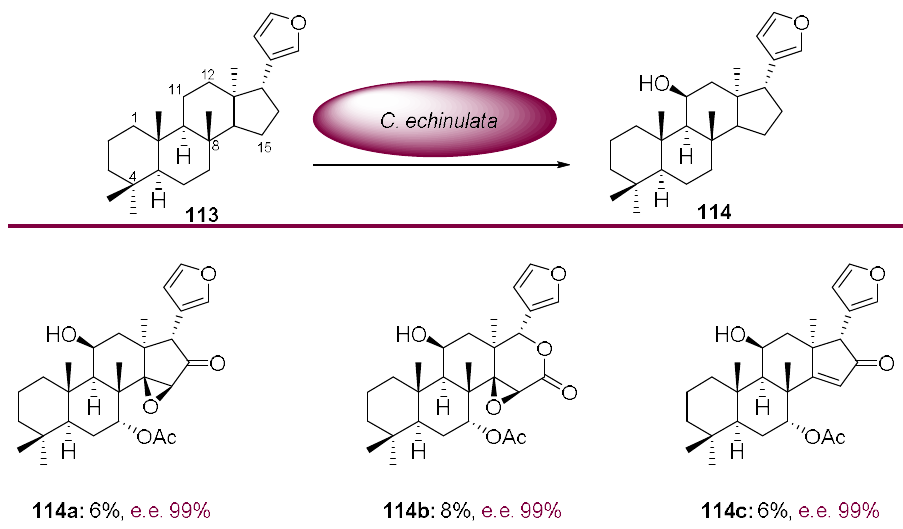
Scheme 36. Hydroxylation of the basic limonoid skeleton by C.